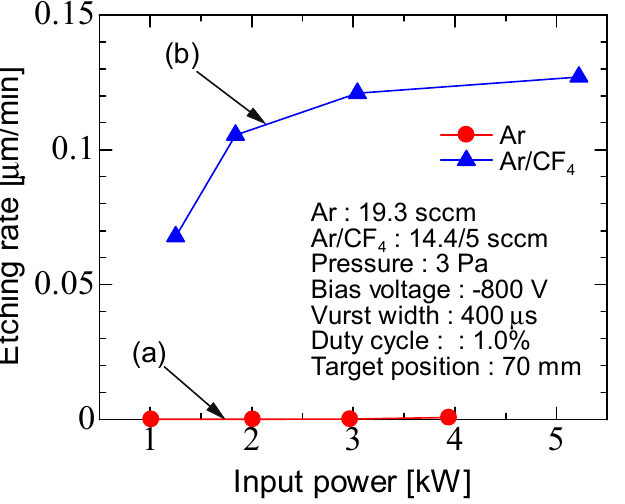
Figure 8. Waveform of target current at each input power. ( a ) Ar discharge and ( b ) Ar/CF 4 discharge.